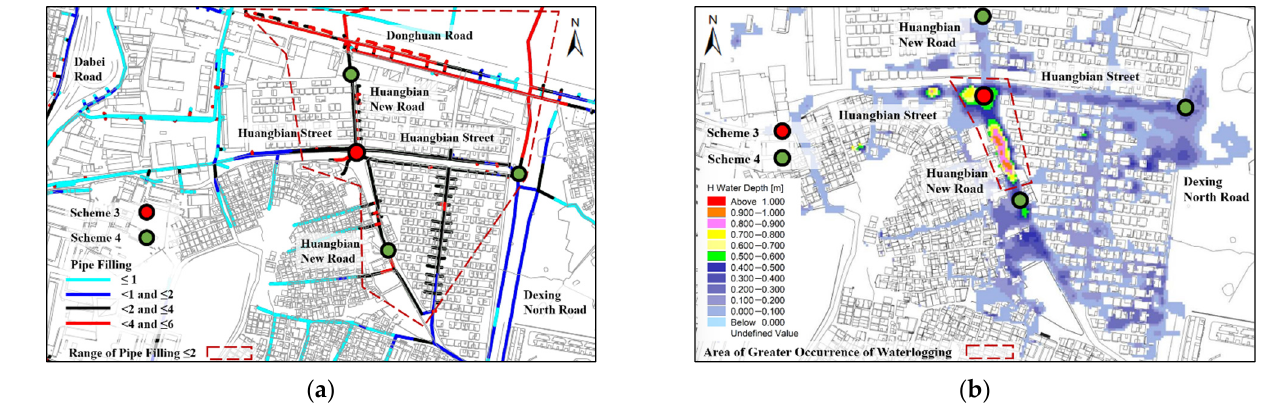
Figure 5. Deployment of stormwater tanks in Schemes 3 and 4. ( a ) Degree of fullness of the pipe network and deployment of stormwater storage tanks; ( b ) The waterlogged area and the deployment of stormwater storage tanks.